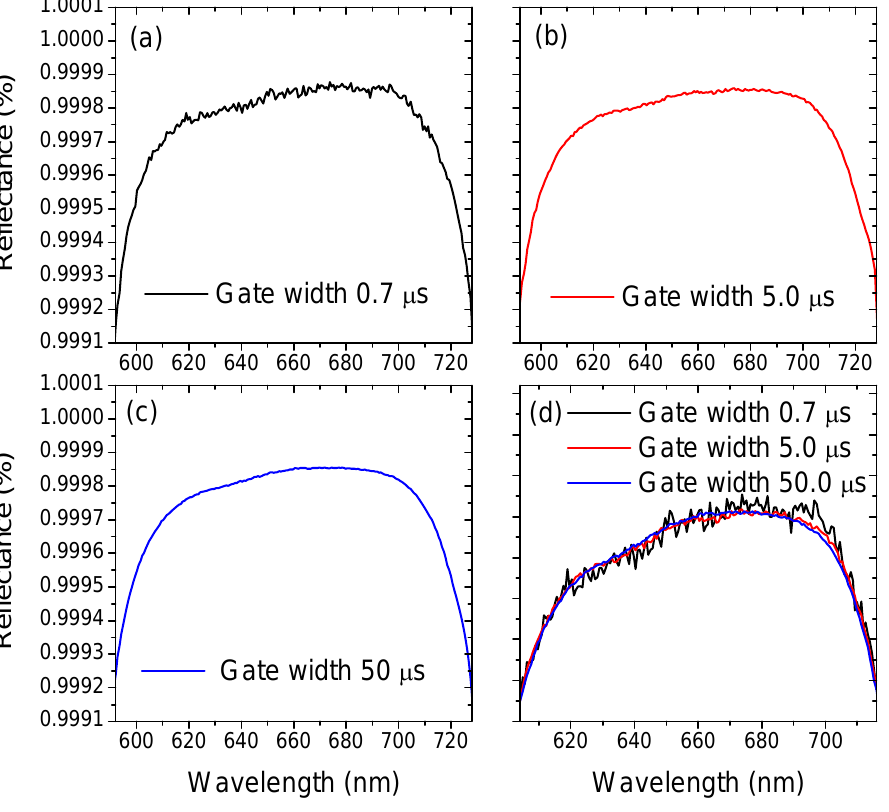
Figure 5. Reflectance of the mirrors of set 2 derived from CRD-Spectrography signals obtained by applying ICCD camera gates of different durations: (a) τ (b) τ = 5.0 μ s, (c) τ = 50 μ s. (d) Reflectivity curves superimposed one on another. g g